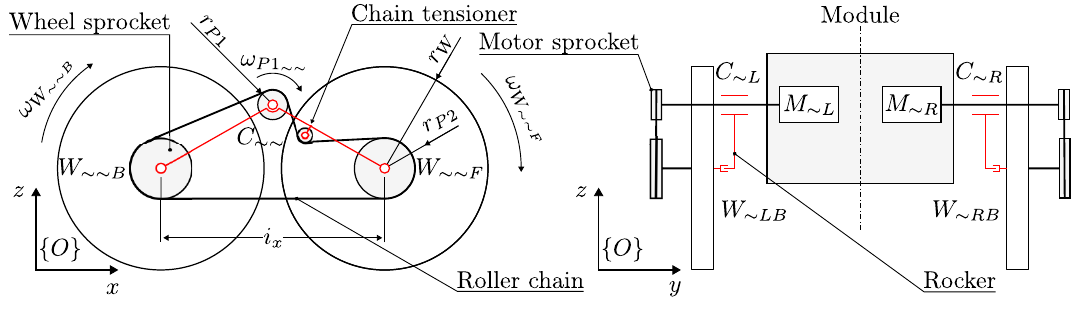
Fig. 5 Rocker mechanism facing an obstacle